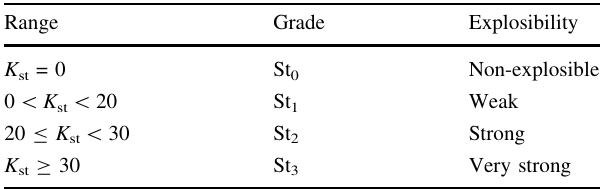
Table 2 Dust explosion hazard grading standard (Fumagalli et al. 2016)